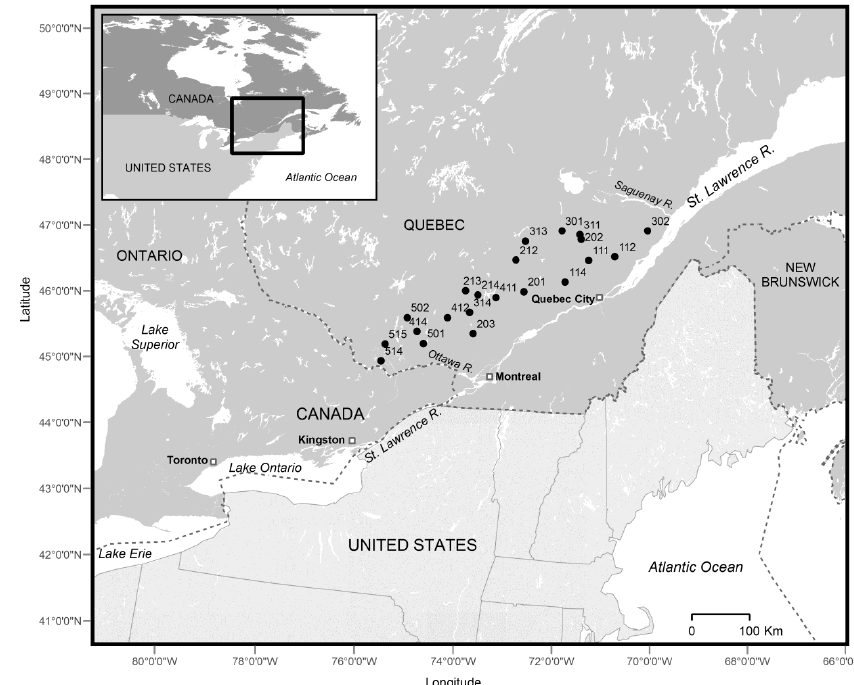
Fig. 1. Locations of the 21 studied catchments in the province of